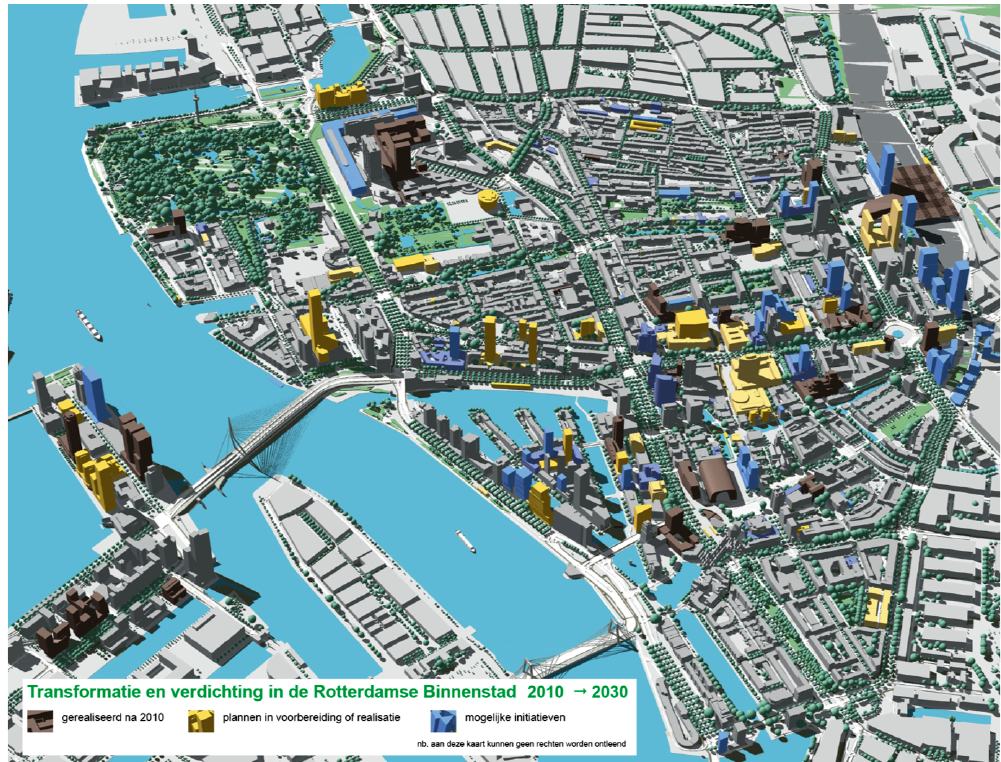
Figure 9. Investigation of on-going and future urban densification in Rotterdam, 2010. Source: Tillie, Borsboom-van Beurden, Doepel and Aarts